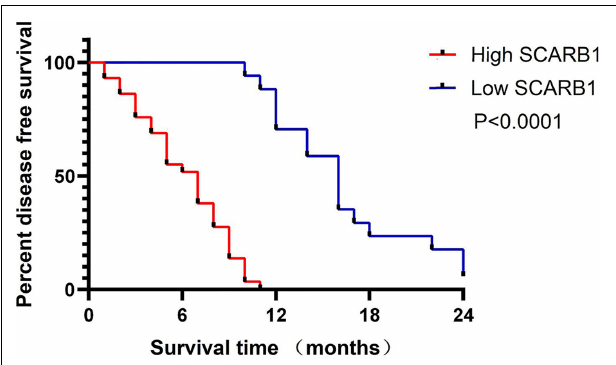
FIGURE 11 | Kaplan-Meier analysis of the survival rate of patients with HCC. Disease-free survival of all patients in relation to SCARB1 expression ( p <